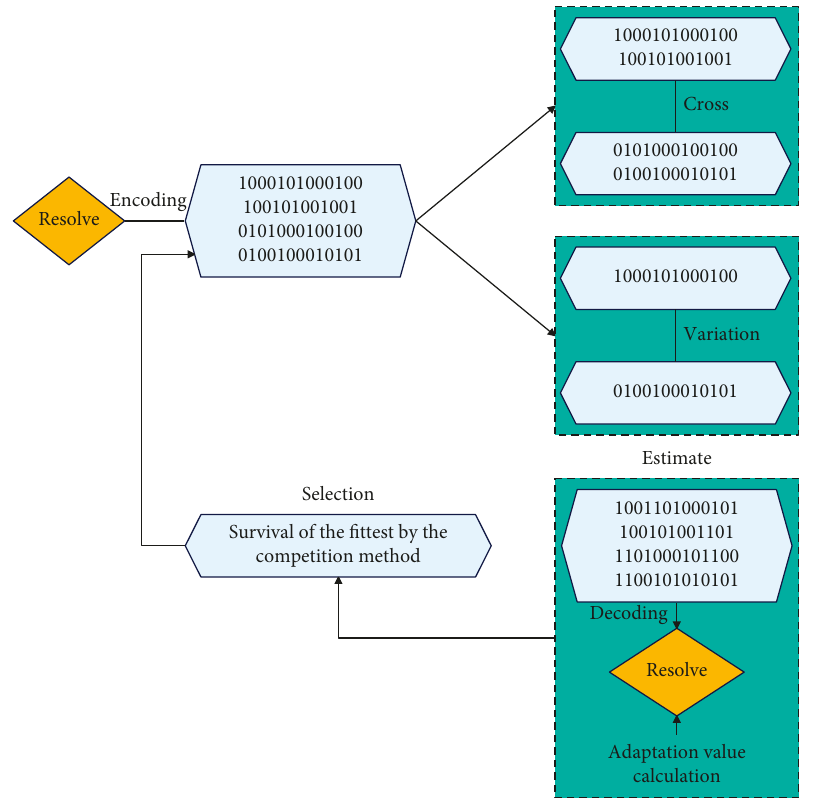
Figure 3: Genetic algorithm coding optimization